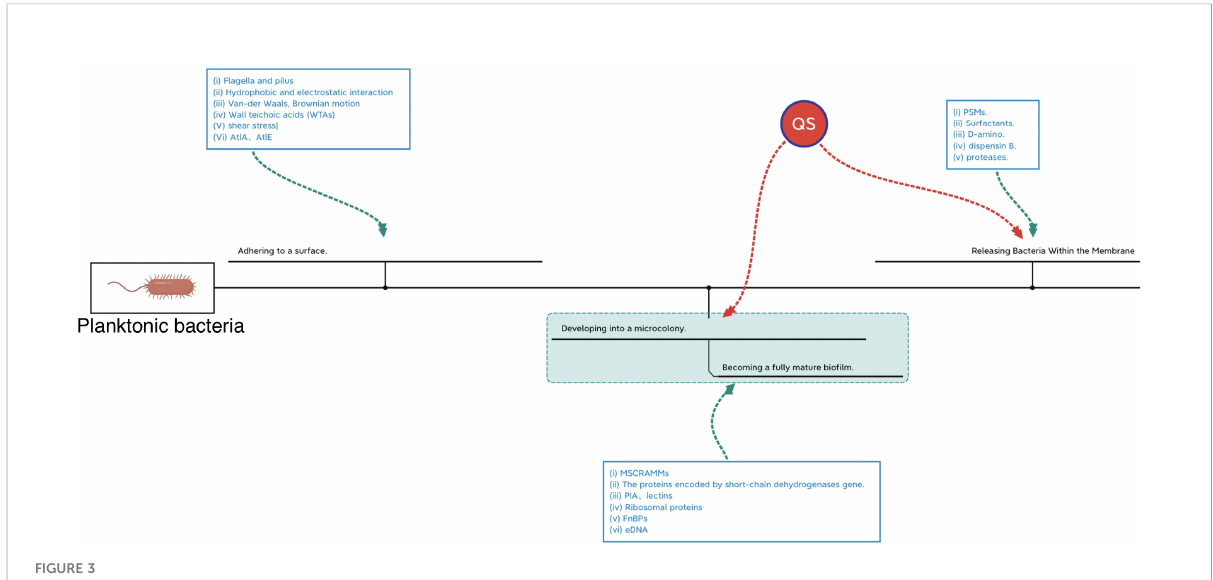
FIGURE 3 Regulating networks in different periods of bio fi lm